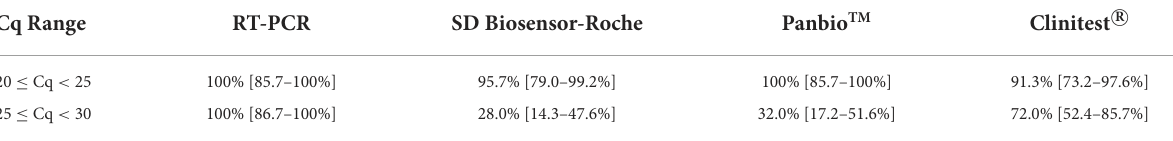
TABLE 1 Precision measurement of the diagnostic sensitivity of the RATs in the two Cq ranges (20 ≤ Cq < 25 and 25 ≤ Cq < 30) with their 95% confidence interval (CI). Cq